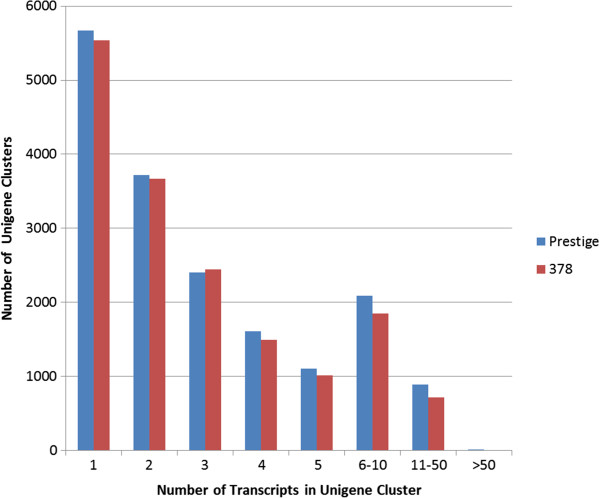
Histogram of Unigene clusters in ‘Prestige’ and ‘378’ cultivars. X-axis lists how many transcripts are in a unigene, and Y-axis lists how many unigenes are of that size.